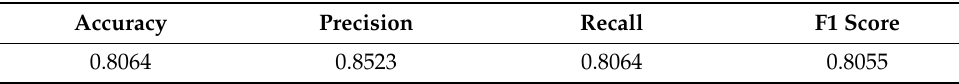
Table 3. XGBoost classification results in the test dataset.